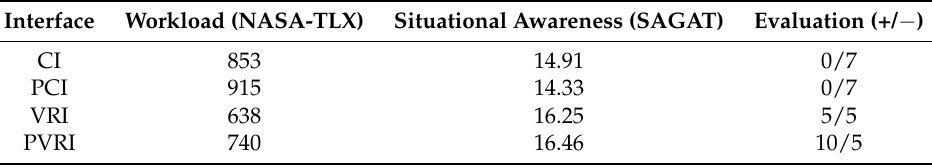
Table 6. Summary of the results of the